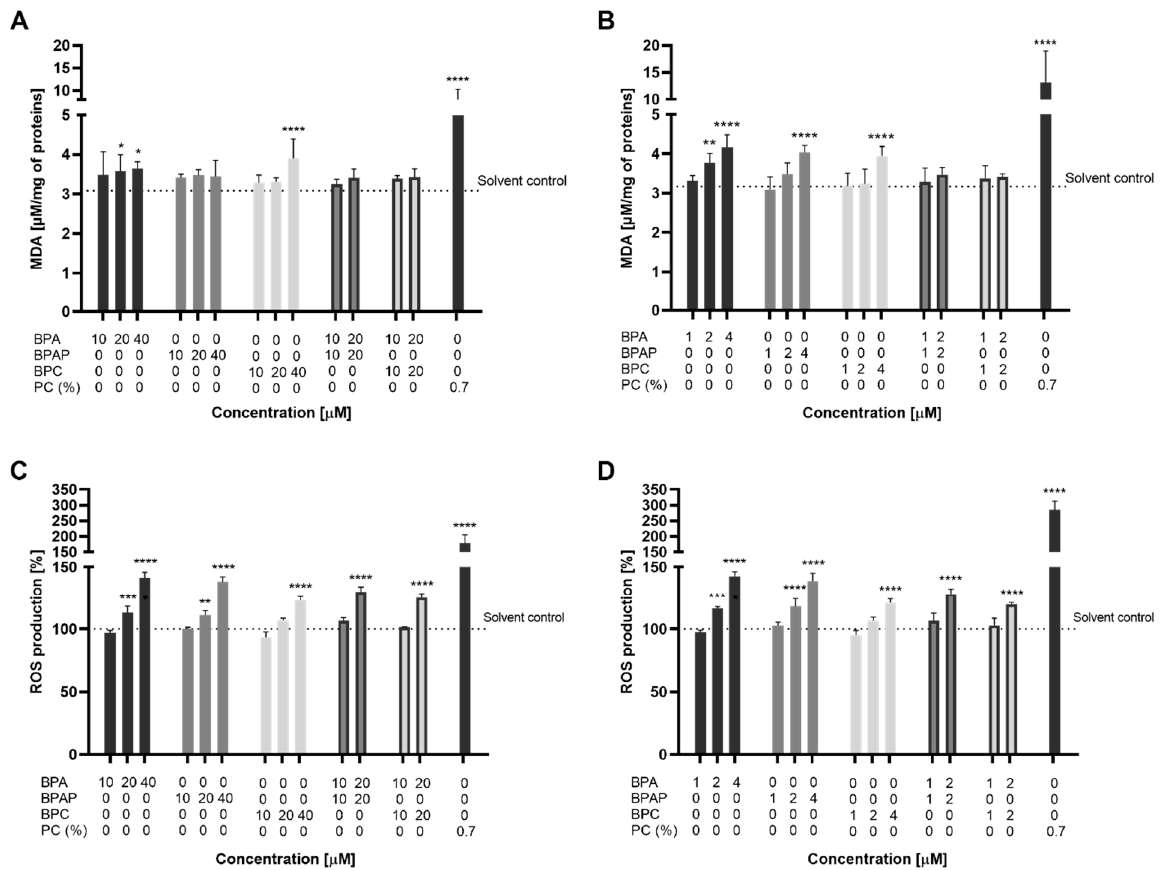
Figure 4. Determination of oxidative stress by TBA assay (MDA) ( A , B ) and DHE fluorescent probe (ROS production) ( C , D ) after exposure to BPA, BPAP, BPC and their binary mixtures for 24 h ( A , C ) and 96 h ( B , D ). PC—positive control (Luperox ® TBH70X (0.7 µ M). * different from solvent control, * p < 0.05; ** p < 0.01; *** p < 0.001; **** p < 0.0001 (One-way ANOVA; Dunnett’s multiple comparison test).